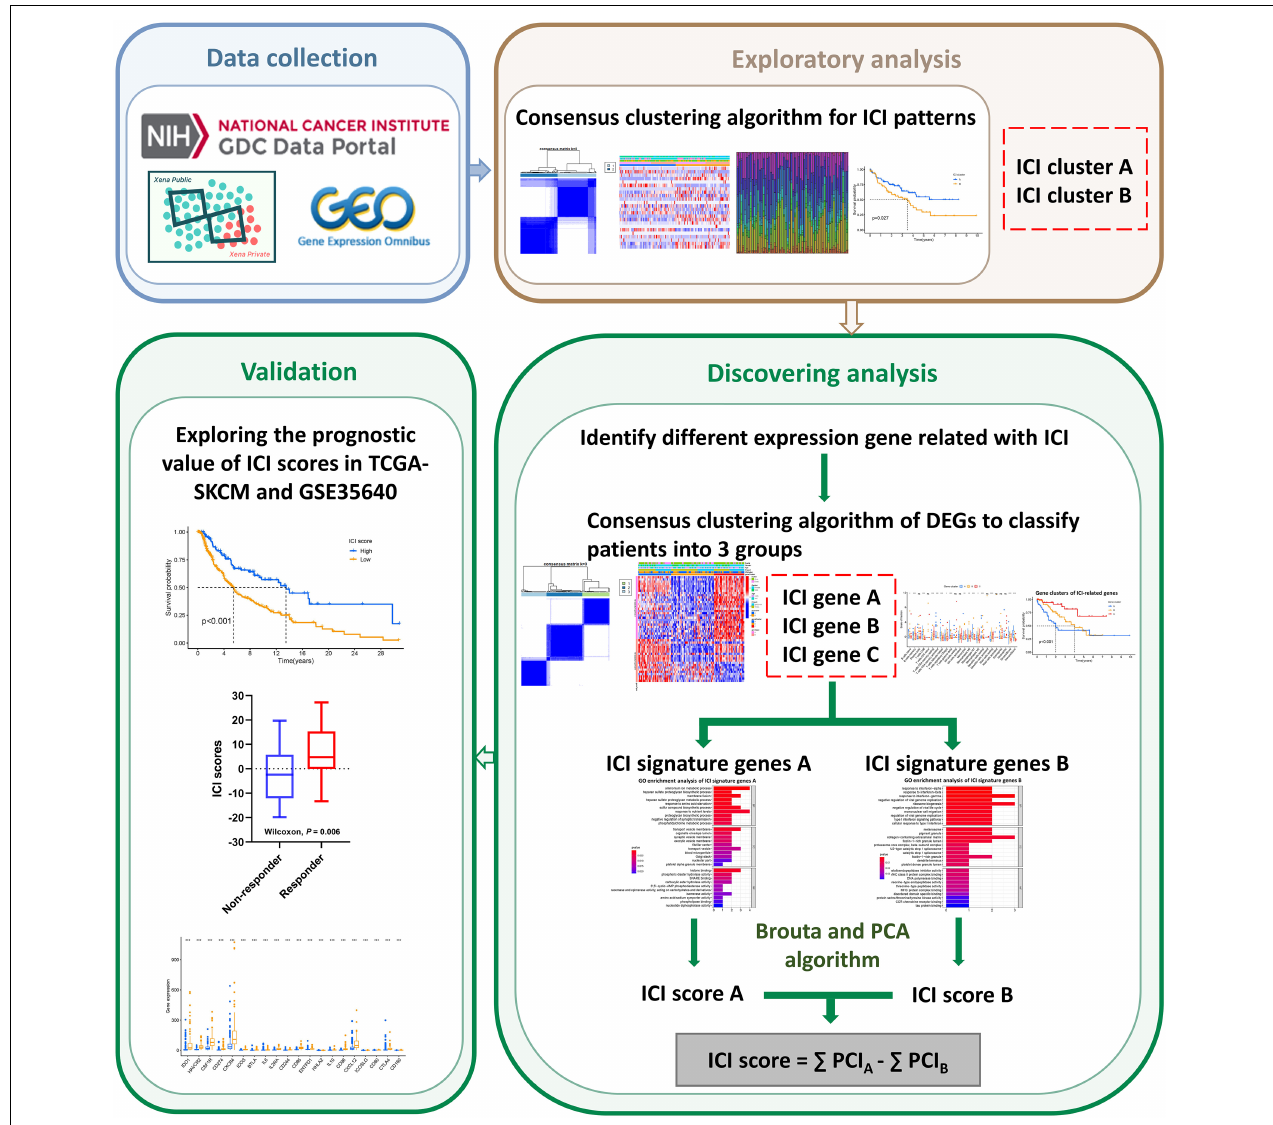
FIGURE 1 | Flow chart of the